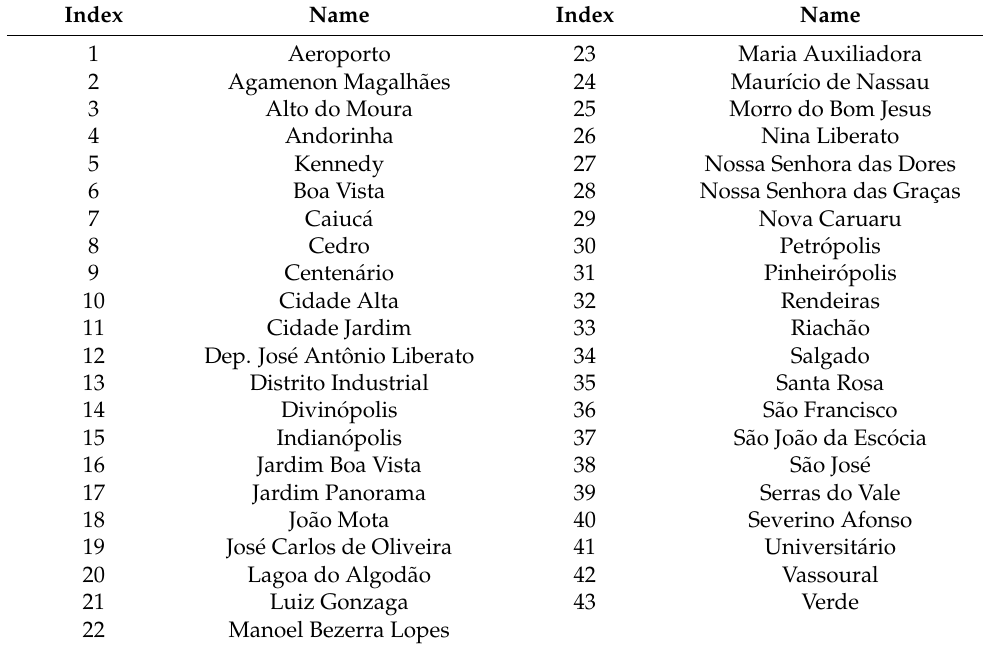
Table 1. Nomenclature of the neighborhoods of